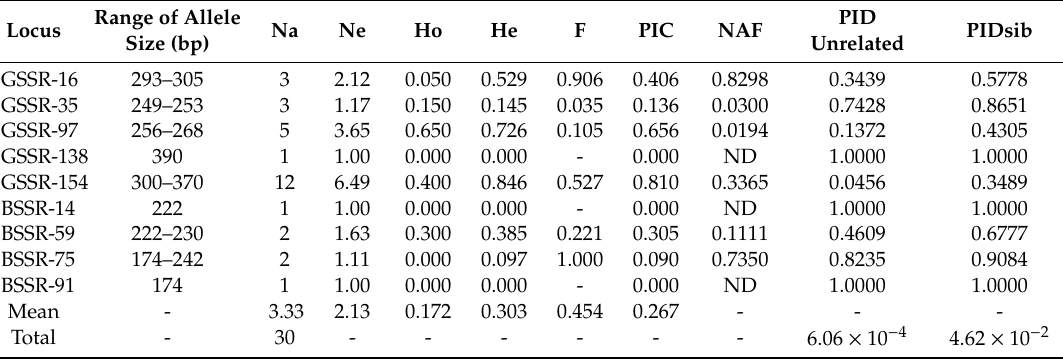
Table 3. Genetic diversity as expressed in terms of allele size (bp), number of alleles (Na), e ff ective number of alleles (Ne), observed (Ho) and expected (He) heterozygosity, inbreeding coe ffi cient (F), polymorphic information content (PIC), null alleles frequency (NAF), and probability of identity (PID and PIDsib) of the 21 fennel